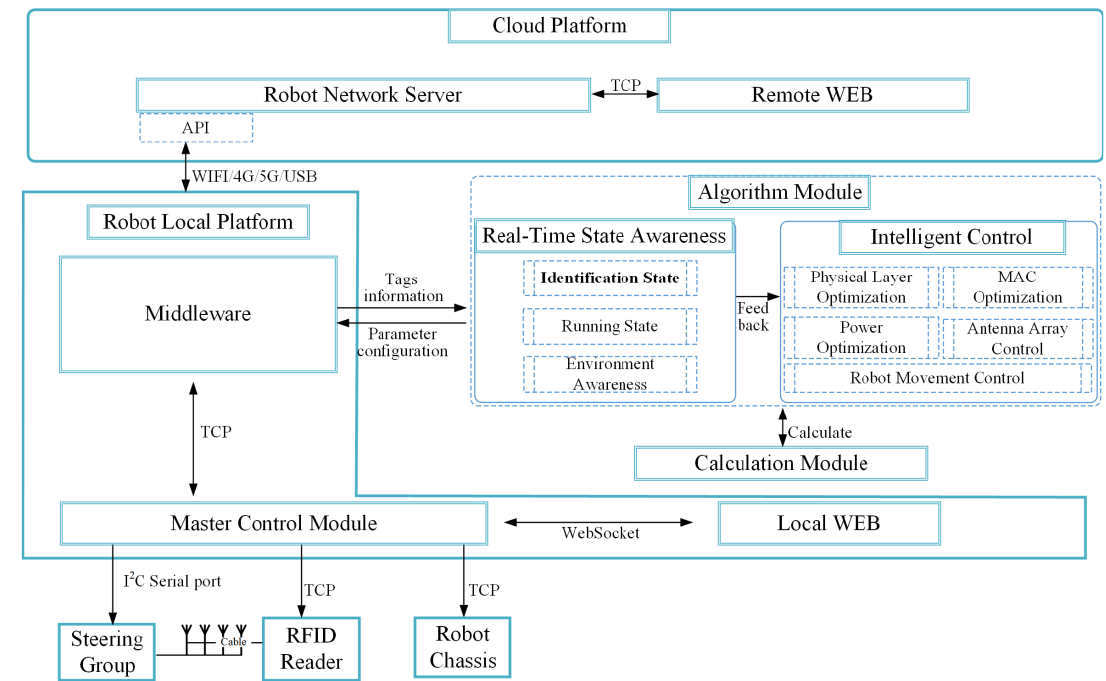
Figure 3. The software architecture of the RFID robot systems.